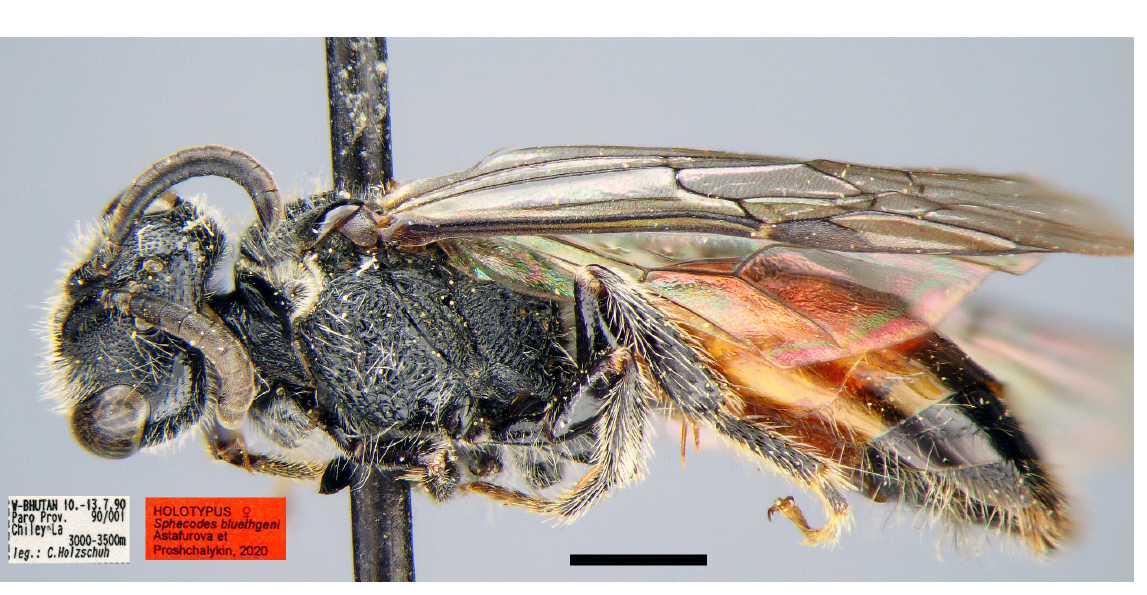
Fig. 6. Sphecodes bluethgeni sp. nov. Holotype, ♀ (PCMS/OLBL). Habitus in lateral view and labels. Scale bar = 1